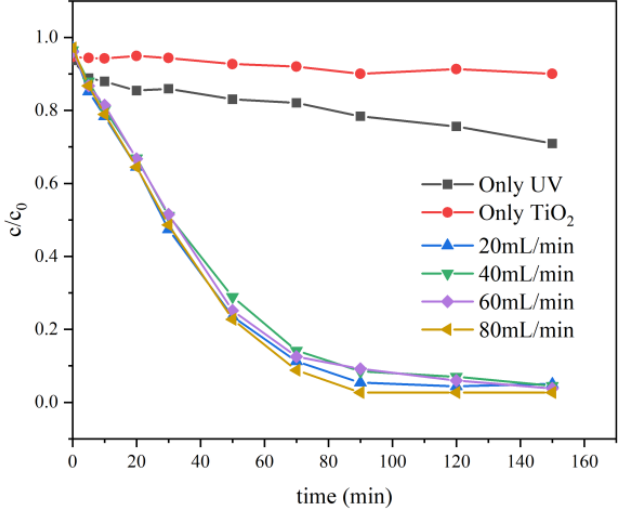
Figure 2. Concentration variation of AR 26 at sewerage flow rates of 20, 40, 60, and 80